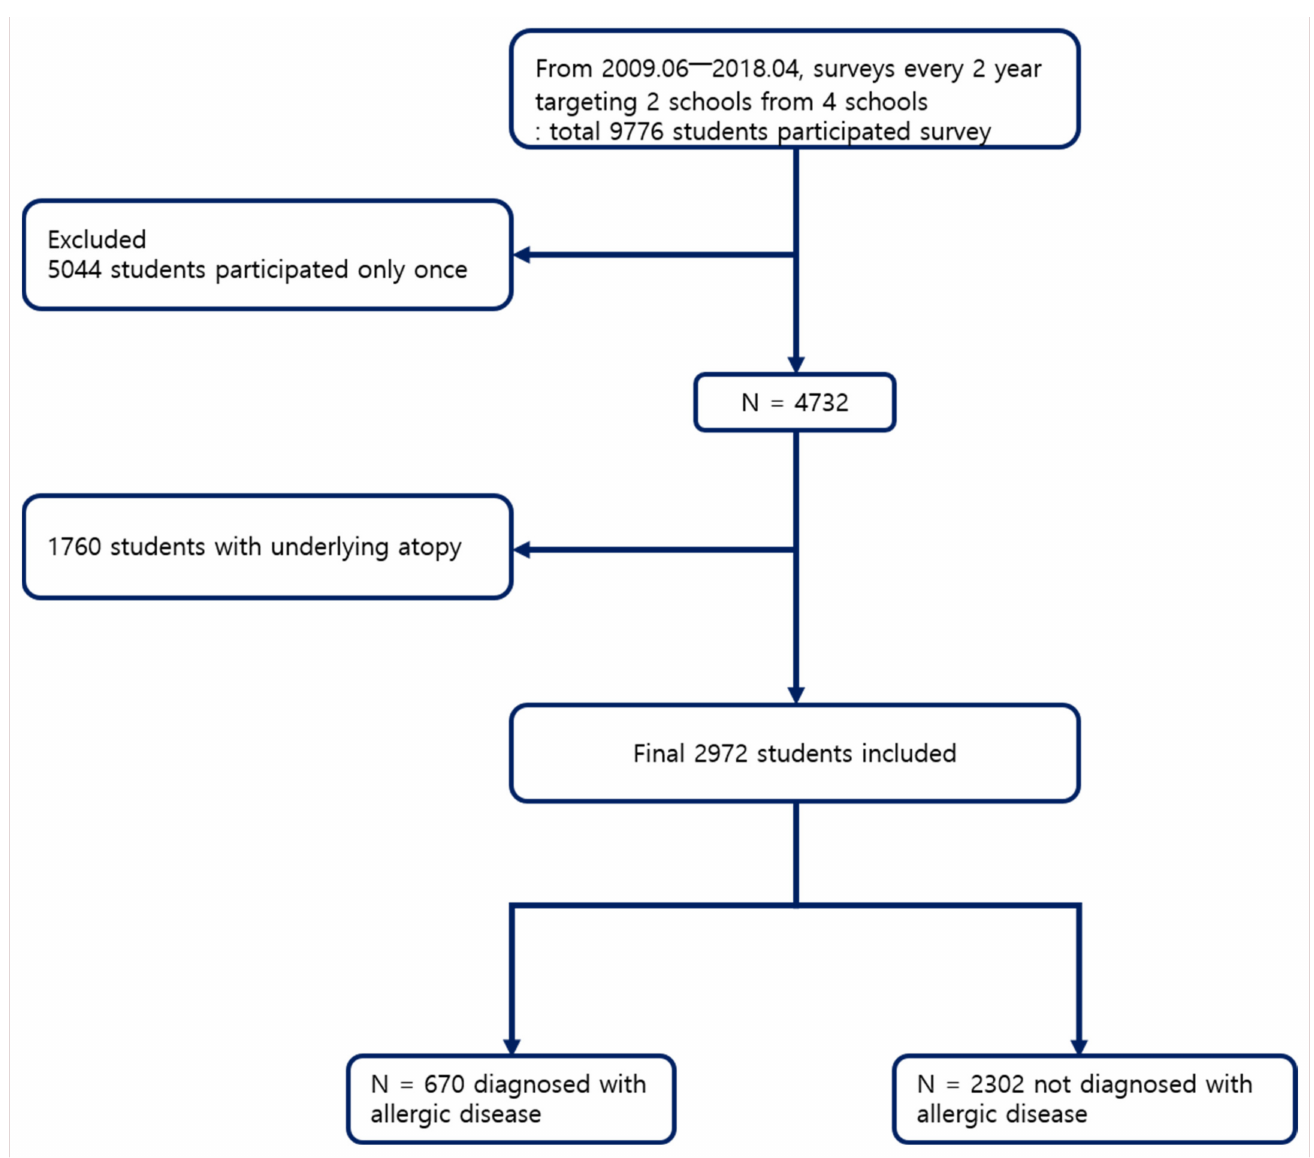
Figure 2. Flow chart of the subject selection